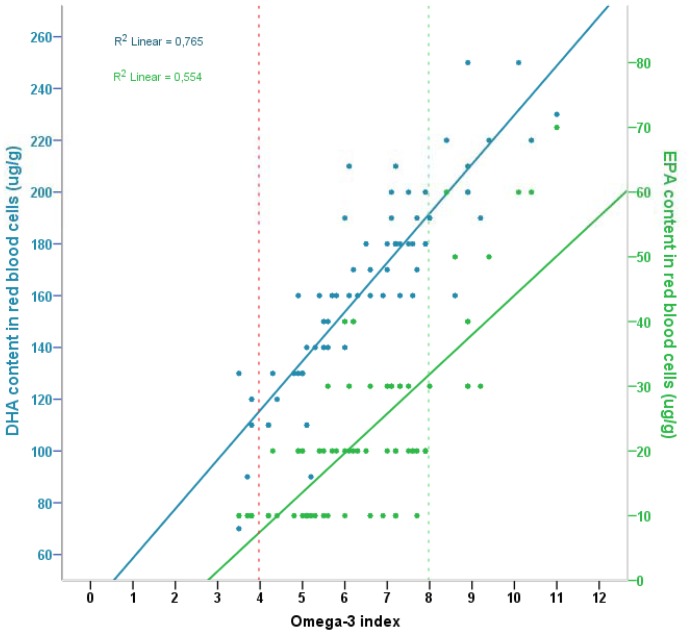
Association between the omega-3 index and absolute DHA and EPA in red blood cells.Scatter plot of the omega-3 index and the corresponding DHA content (µg/g) and EPA content (µg/g) in red blood cells, and the respective fitted regression lines. The omega-3 index is the content of EPA+DHA in red blood cells membranes expressed as a percent of total fatty acids.